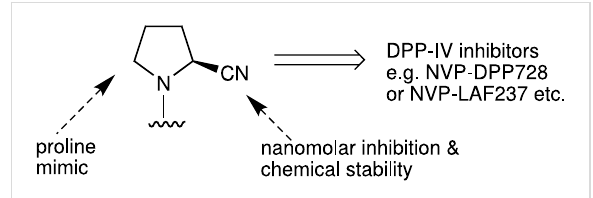
Figure 2: Role of 2( S )-cyanopyrrolidine moiety in DPP-IV inhibition.